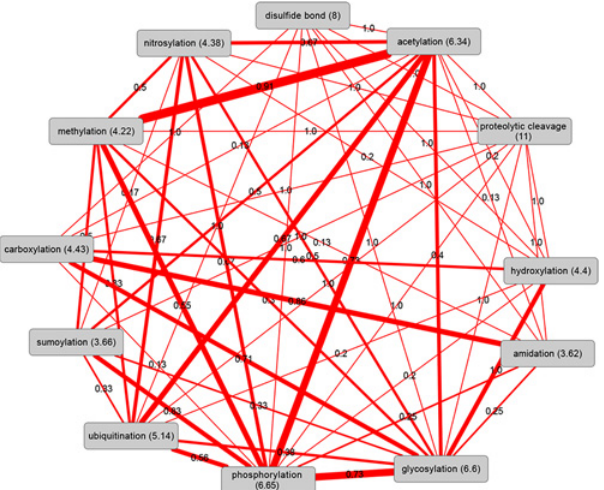
Figure 3. Significant co-existence pairs of PTM-types across all selected species. Edge width was set proportionally to the number of species in which a particular PTM pair was found to occur more frequently than expected (see legend to Fig. 2) at significance levels of FDR-corrected p -values < 0.01. The values on the edges indicate the number of species with significant co-existence normalized by the number of common species between each pair of PTM-types as not all PTM-types are present in all species based on our filtering criteria (see Methods). Numbers in parentheses are the normalized counts of significant “ red ” co-existence edges to other PTM-types.